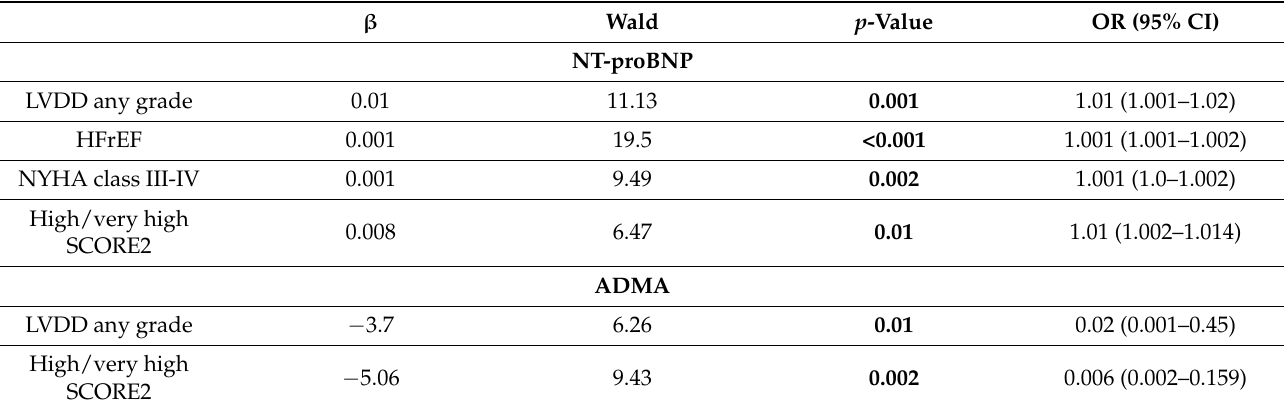
Table 5. Logistic